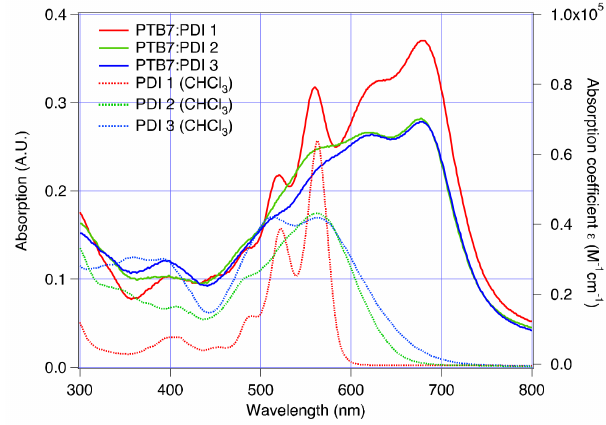
Figure 1. UV-Vis spectra of the PDI acceptors in chloroform (dotted line, right axis); UV-Vis spectra of active layers (PTB7:PDI) processed using deposition parameters from the fabrication of optimized devices (solid line, left